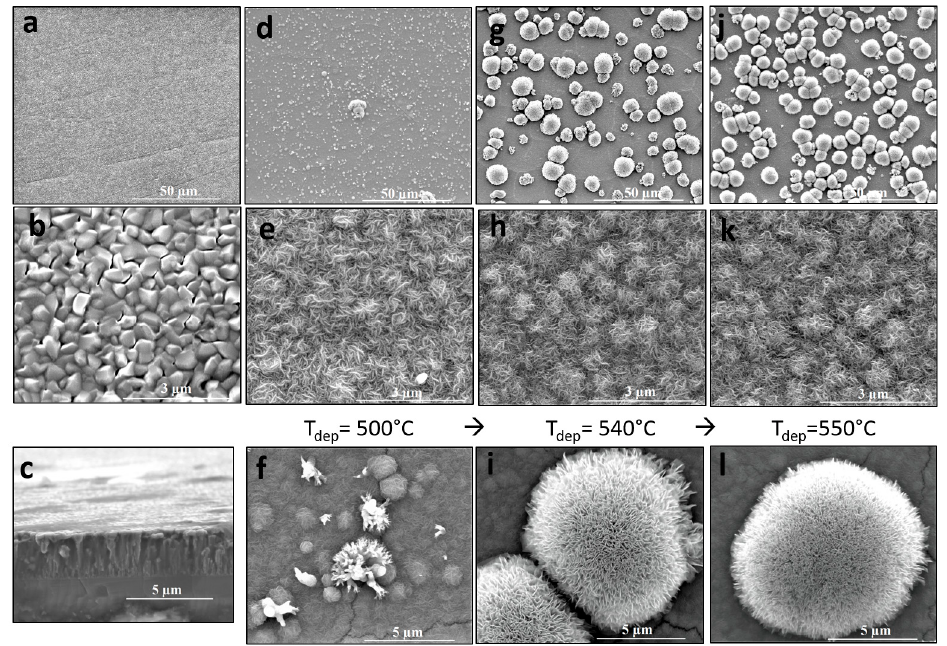
Figure 1. SEM images of samples: ( a – c ) Al–Zr (4 at.% Zr) coating, and TiO 2 films deposited at ( d – f ) 500 °C, ( g – i ) 540 °C, and ( j – l ) 550 °C.